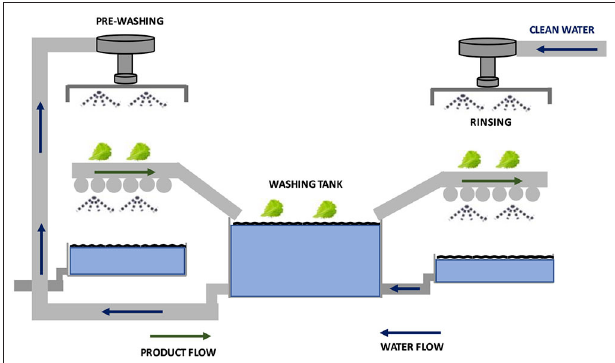
FIGURE 2 | Schematic diagram of the washing/disinfection processing unit for fresh-cut